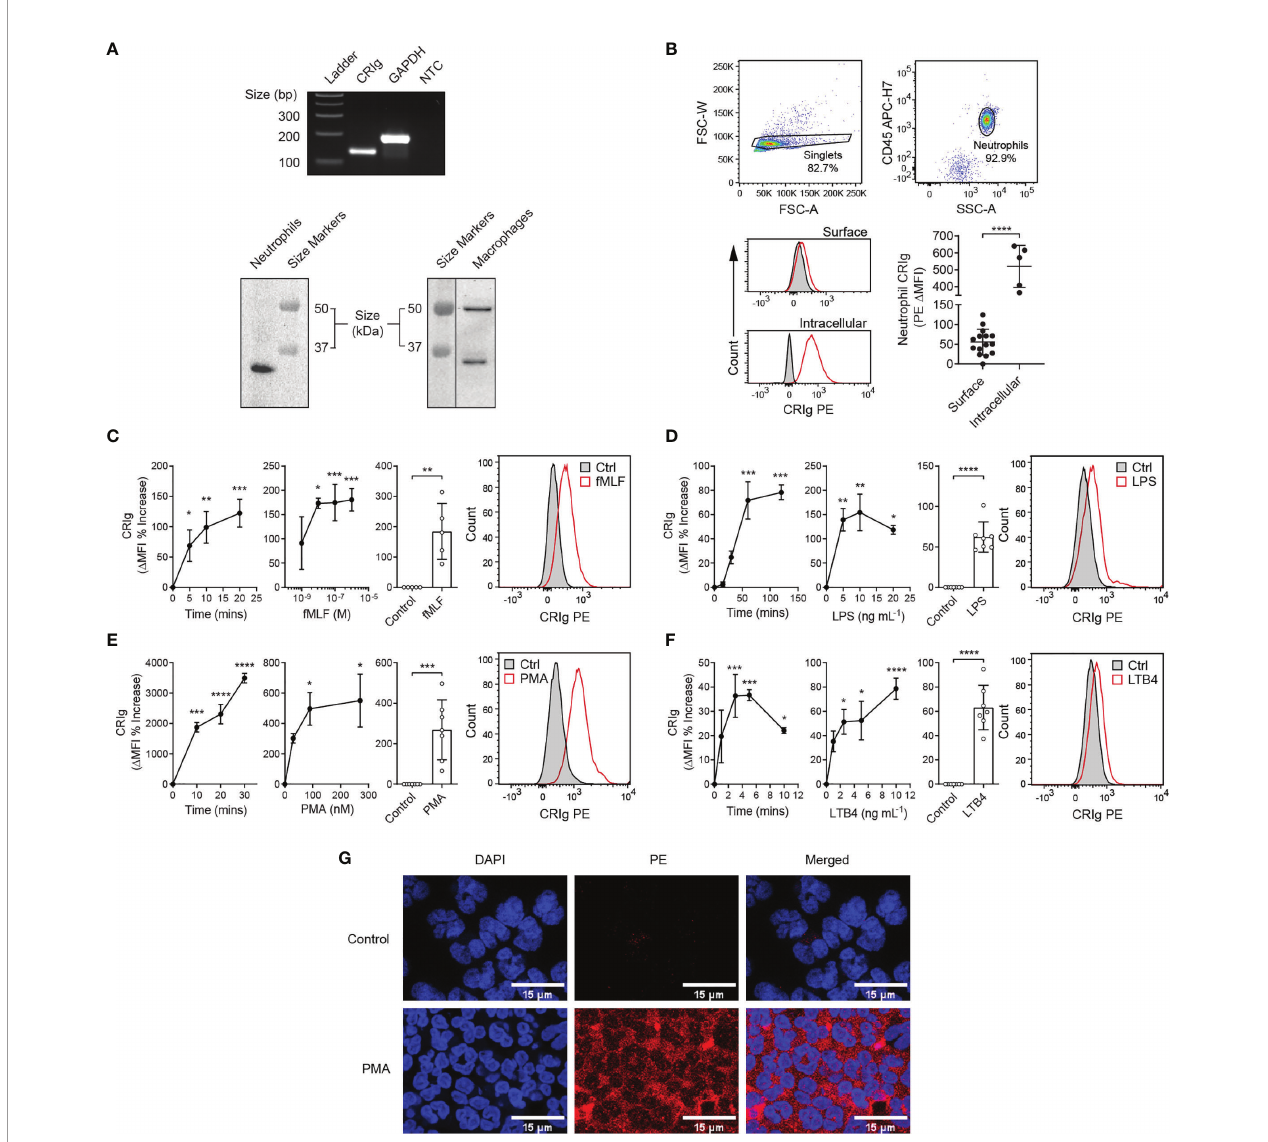
FIGURE 1 | Expression of CRIg by human neutrophils. (A) Representative gel of CRIg ( VSIG4 ) and GAPDH cDNA amplicons from neutrophil RNA (top) and Western blot of neutrophil (lower left) and MDM (lower right) lysates stained using anti-CRIg (clone 6H8) monoclonal antibody. NTC, no template control. (B) Surface and intracellular CRIg expression in neutrophils, including gating strategy with histogram overlays of PE anti-CRIg antibody (red line) and isotype control (black line with grey shading) staining. Bottom graph shows MFI of CRIg PE minus isotype control ( D MFI) for surface ( n = 15 individuals) and intracellular ( n = 5 individuals) staining. Data are presented as individual values and as mean ± SD. Two-tailed, unpaired t-test with Welch ’ s correction compared with surface expression. One-way analysis of variance (ANOVA) with Tukey ’ s post-test compared between all sample types. (C – F) CRIg expression on activated neutrophils. Upper panels show changes in CRIg expression on the surface of neutrophils over time in response to fMLF (10 -6 M), LPS (10 ng/mL), PMA (100 nM), and LTB4 (5 ng/mL). Middle panels show representative histograms. Lower panels show agonist concentration related effect at 20 min (fMLF), 60 min (LPS), 20 min (PMA), and 5 min (LTB4). Expression was calculated as D MFI and then these were expressed as a percentage increase over control treatment ( n = 3 experiments). Summary of the stimulation of neutrophil CRIg expression by fMLF, LPS, PMA and LTB4 at optimal times (20, 60, 20, and 5 min, respectively) and concentrations (10 -6 M, 10 ng/mL, 100 nM and 5 ng/mL, respectively). Measurements were taken from distinct specimens and graphs show mean ± SD of these experiments. (G) Shows CRIg expression on PMA (100 nM)- activated neutrophils by confocal microscopy. DAPI has been used to stain the cell nucleus to locate cells and PE labelled anti-CRIg for CRIg expression. Statistical analyses (C – F) , One-way ANOVA with Dunnett ’ s post-test compared with expression at the start of the time-course or in the absence of added in fl ammatory mediator. (G) Kruskal-Wallis test with uncorrected Dunn ’ s post-test compared with control treatment. Signi fi cance levels are indicated by asterisks: * P < 0.05, ** P < 0.01, *** P < 0.001, **** P <